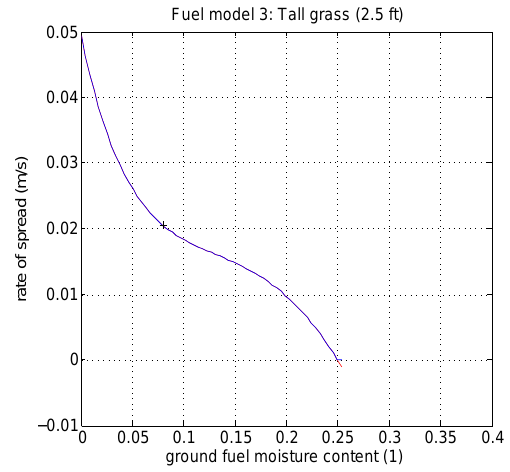
Figure 1. Illustration of the dependence of rate of spread on fuel- moisture content in Rothermel’s model. The rate of spread for Anderson (1982) fuel model 3 with zero wind and slope is